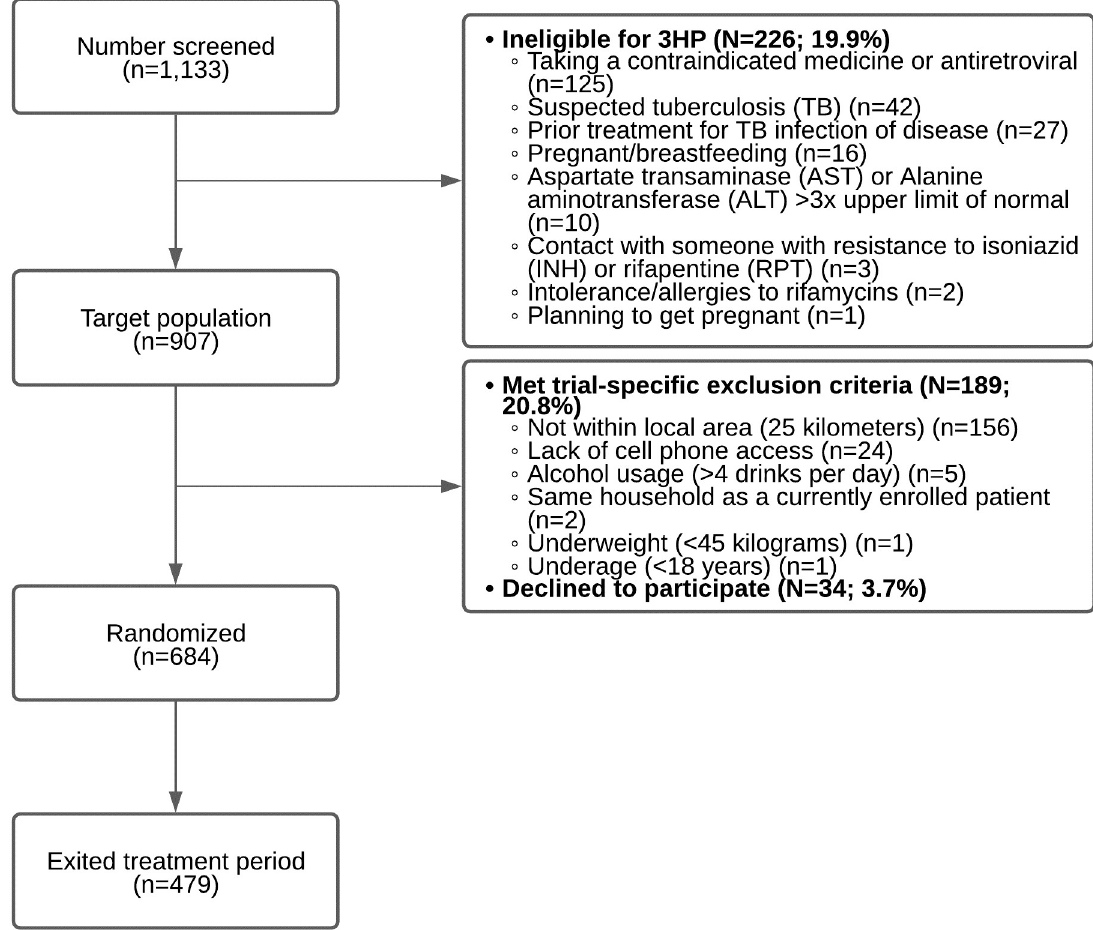
Fig 1. CONSORT flow diagram. 3HP Options Trial screening , randomization, and allocation, July 13, 2020 to April 30, 2021 ( n = 1,133). ALT, alanine aminotransferase; AST, aspartate transaminase; CONSORT, Consolidated Standards of Reporting Trials; INH, isoniazid; RPT, rifapentine; TB,